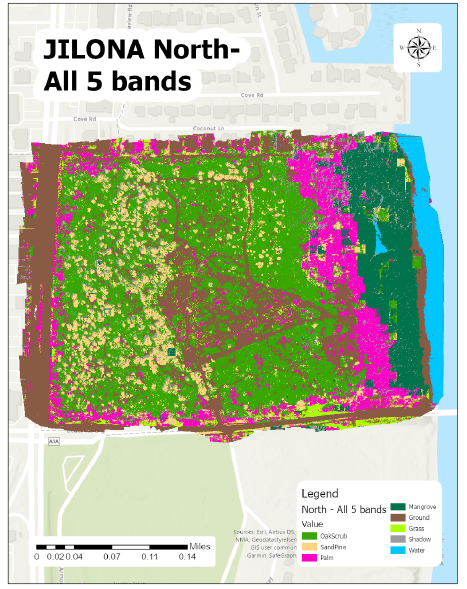
Figure 12: JILONA north classification using all 5 bands